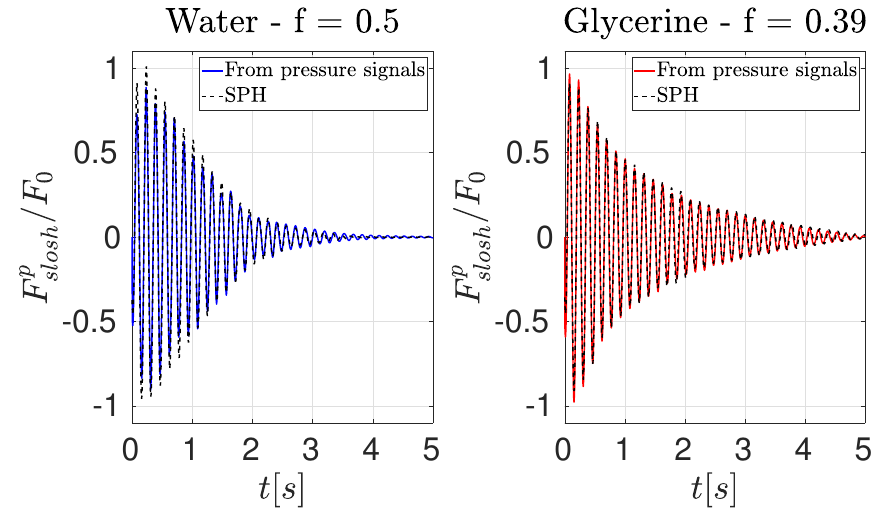
Figure 21. Comparison between the pressure contribution to the SPH sloshing force and the sum of the local force measured by the sensors.